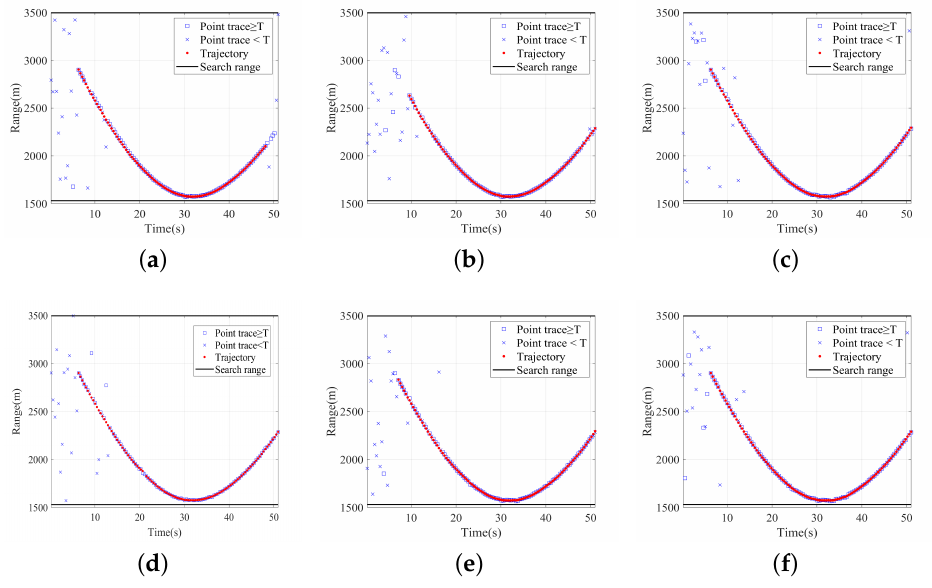
Figure 19. The results of real data under EI-GRFT, EI-HGRFT, DT-GRFT, DT-HGRFT, twice DT-GRFT joint detection and twice DT-HGRFT joint detection. ( a ) The result of EI-GRFT. ( b ) The result of EI-HGRFT. ( c ) The result of DT-GRFT. ( d ) The result of DT-HGRFT. ( e ) The result of twice DT-GRFT joint detection. ( f ) The result of twice DT-HGRFT joint